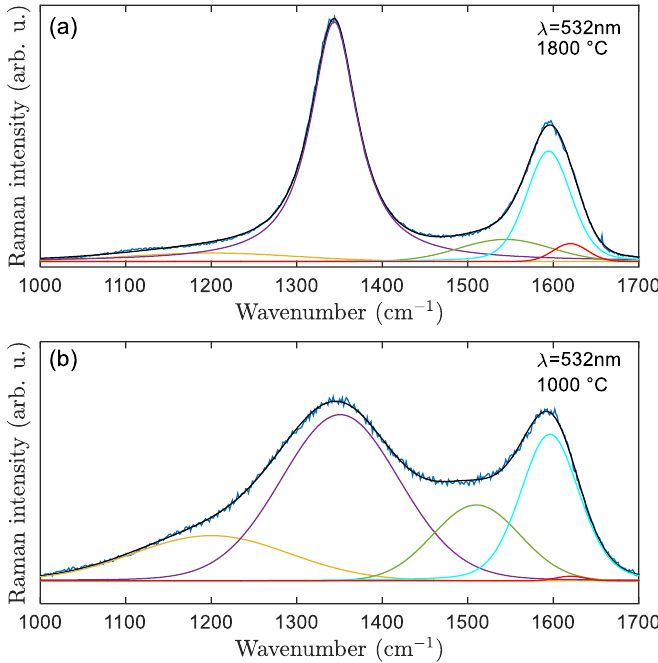
Figure 6. Raman spectra of cellulose carbonized at ( a ) 1800 and ( b ) 1000 ◦ C obtained with an excitation wavelength of 532 nm, and fitted with 5 bands (see Table 2): D 1 (purple) and G (blue), added with D 2 (red), D 3 (green), and D 4 (yellow).